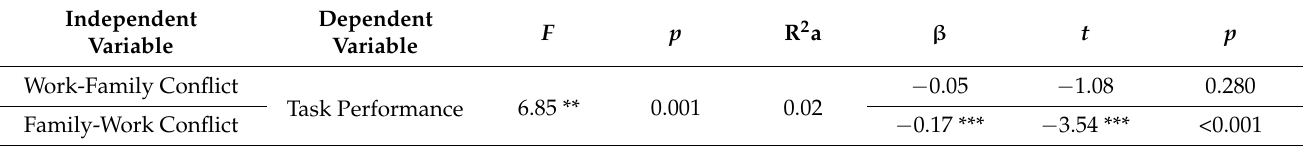
Table 4. Multiple linear regression results